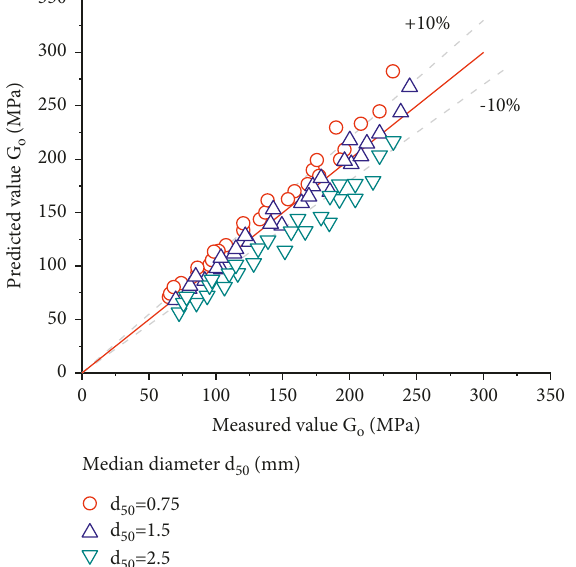
Figure 15: Measured and predicted maximum shear modulus G of the calcareous sand with different values of d 50.